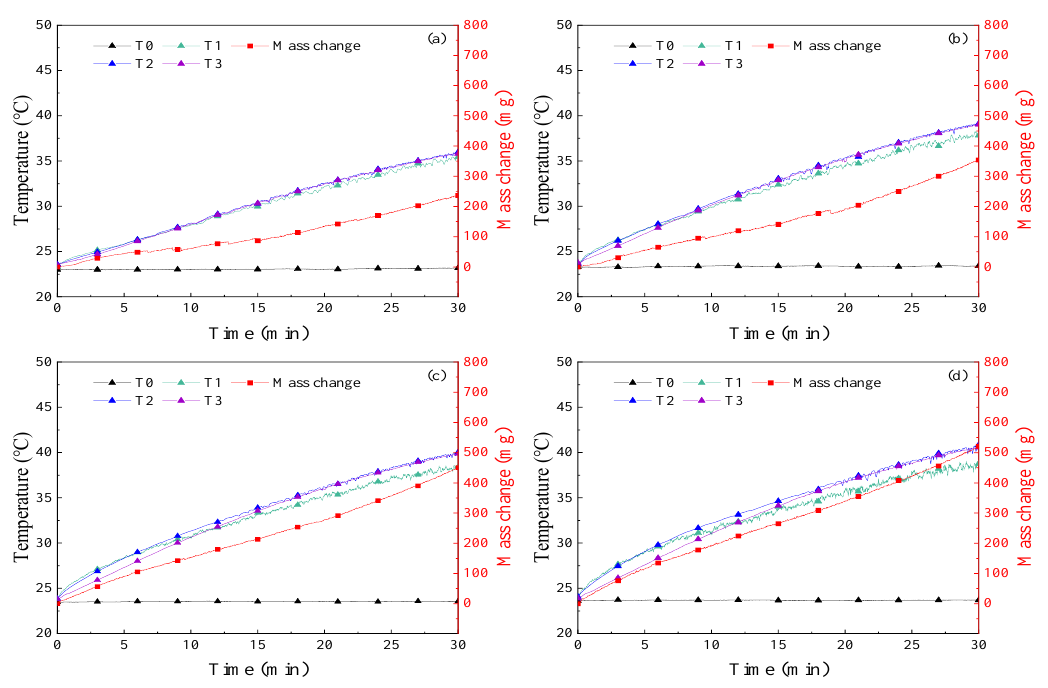
Figure 7. Curves of temperature and mass change of Au nanofluids in experiments on solar – thermal conversion characteristics ( a ) 50 ppm; ( b ) 200 ppm; ( c ) 500 ppm; ( d ) 1000 ppm.